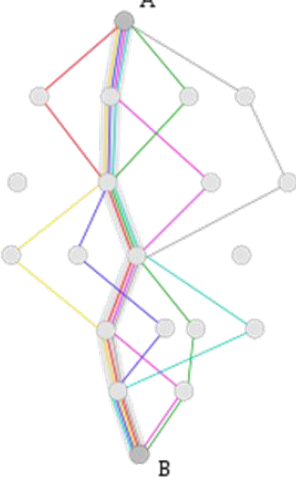
Figure 2. Shortest path using ACO